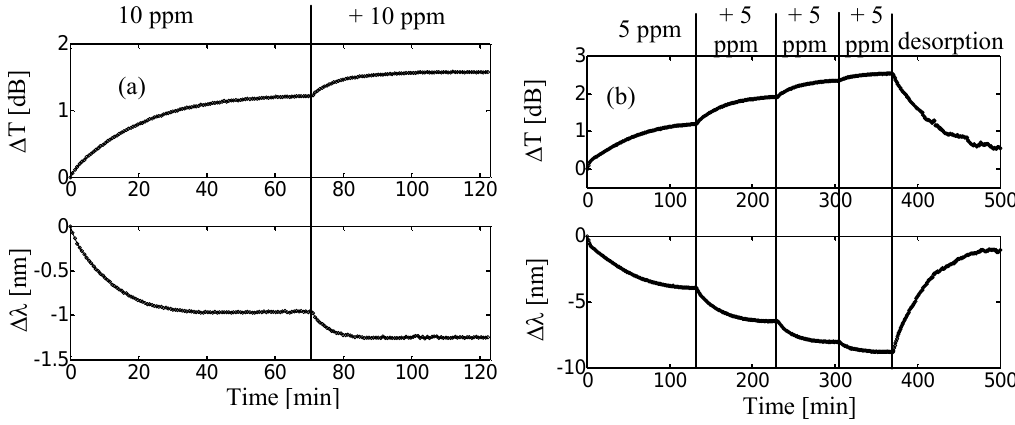
Figure 23. (a) Attenuation band transmittivity and central wavelength changes during analyte sorption for a 160 nm coated LPG. The attenuation band is related to the cladding and is placed in a spectral window around 1,310 nm; (b) attenuation band mode LP 06 transmittivity and central wavelength changes during analyte sorption for a 260 nm coated LPG. The attenuation band is related to the cladding mode LP around 1,550